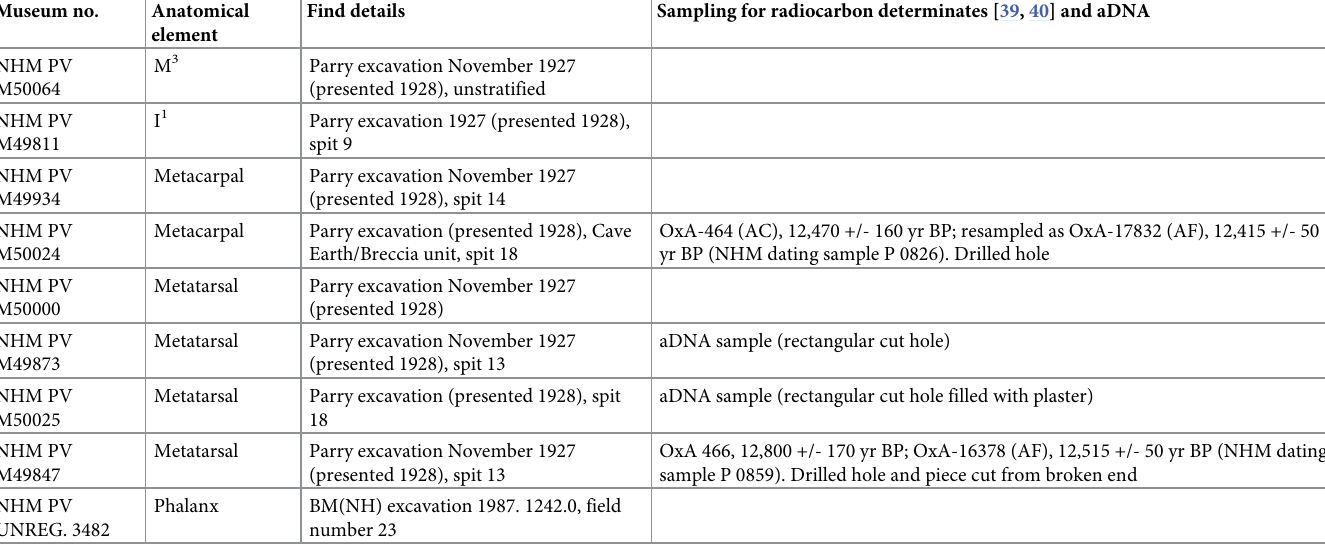
Table 2. Locations and circumstances of discovery, and radiocarbon dates for the knapping tools. Museum